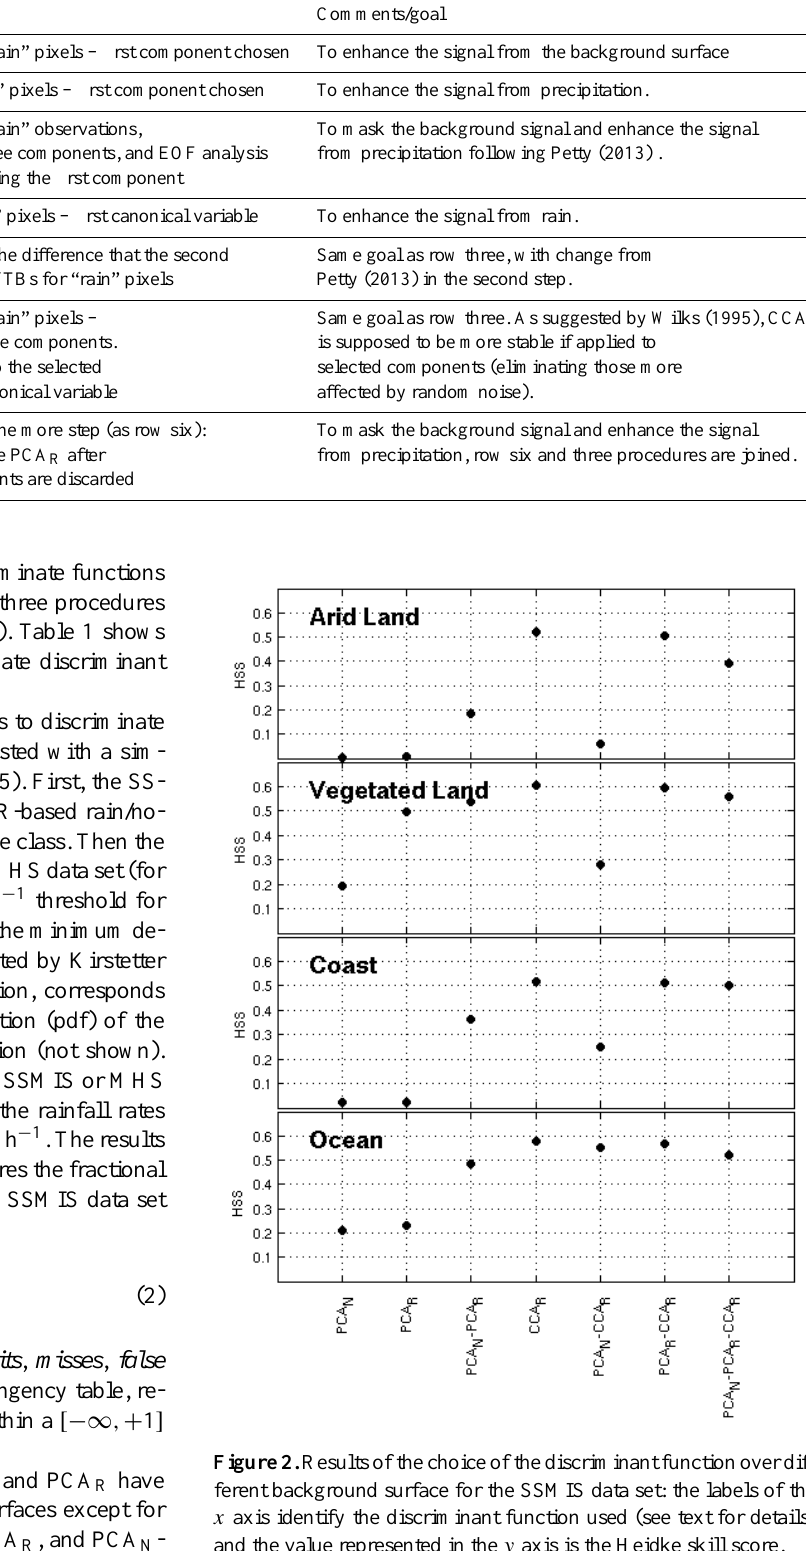
Table 1. Description of the seven-candidate discriminant functions. Discriminant function